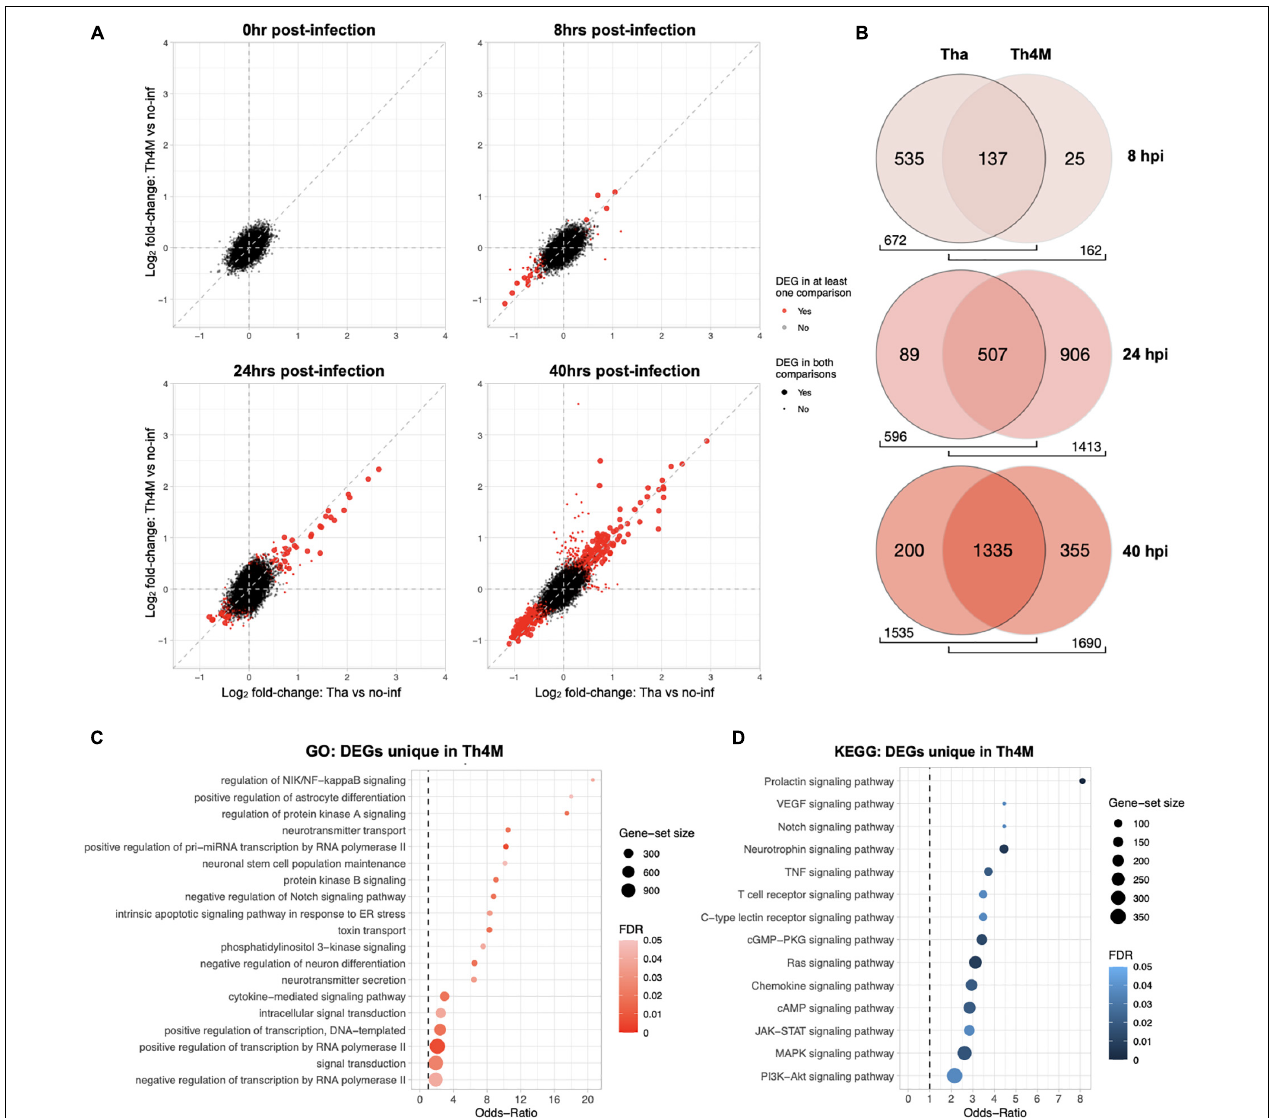
FIGURE 2 | Comparison of Tha and Th4M dataset. (A) From 0 to 40 hpi, DEGs (in red) were progressively selected more at the later time points. The common DEGs between two datasets were marked with a larger dot in red, and DEGs unique to one dataset with a smaller dot in red. The exact number of DEGs can be referred to Table 1 . (B) Th4M dataset shares the majority of associated GO terms (Biological Process) with Tha. As the number of DEGs increases over time, the shared GO terms take the majority of ontology proportion at each dataset. At 8 hpi, Th4M shares 85% of its GO terms with Tha, and at 24 hpi, Tha shares 85% of GO terms with Th4M due to their lower number of DEGs compare to the opponent. At 40 hpi, both datasets share over 79% of GO terms with the other. (C) The list of DEGs from all time-points that are only detected in Th4M dataset was crosschecked with the relevant GO term subset. Both the GO subset and DEG crosschecks are provided in Supplementary Table 6 . (D) Crosscheck of unique DEGs in Th4M dataset with the relevant KEGG pathway